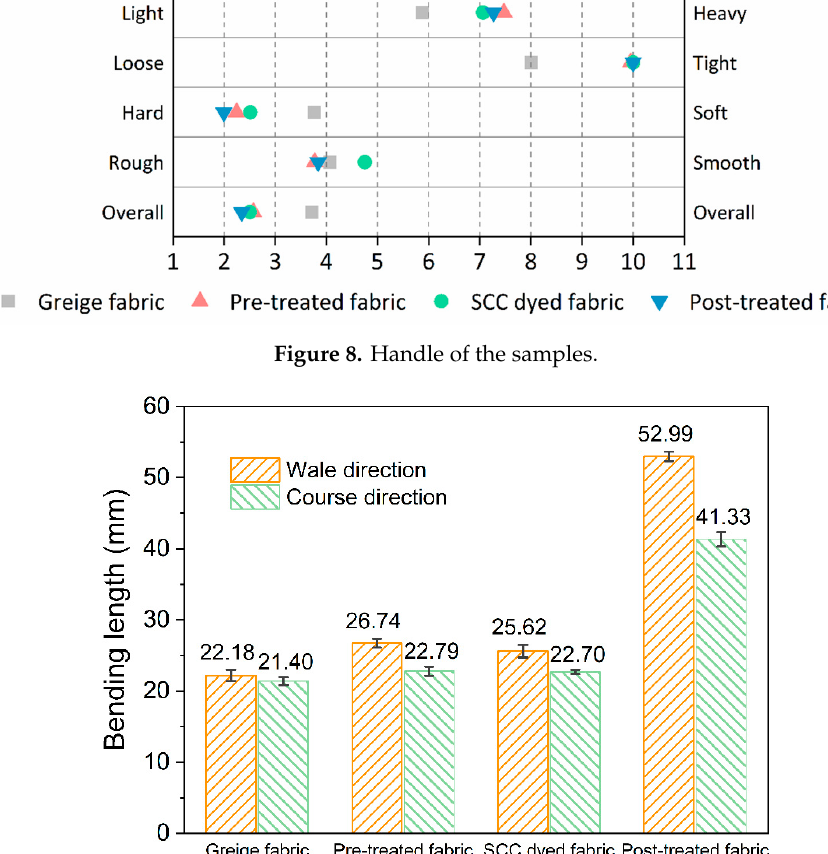
Figure 9. Flexibility of the four samples from the perspective of bending length.